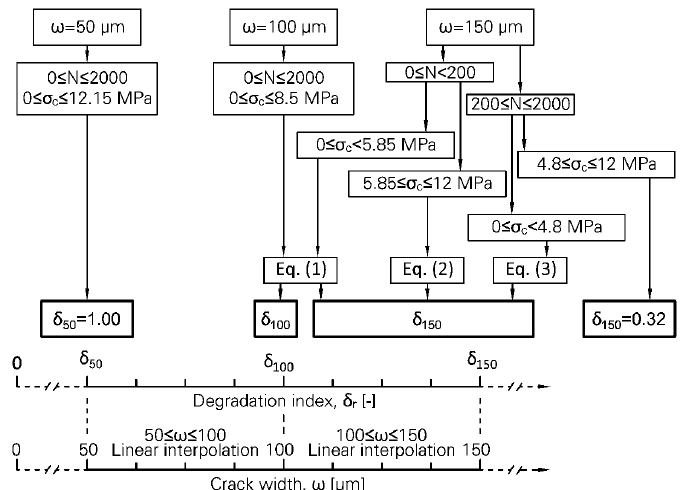
Figure 13. Suggested algorithm for estimation of the crack-bridging capacity of PVA microfibre and degradation under alternating cyclic loading and under consideration of crack its degradation under alternating cyclic loading and under consideration of crack width.